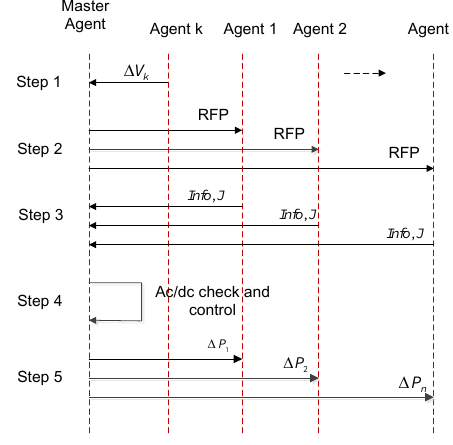
Figure 5. MAS-based overall voltage control process.